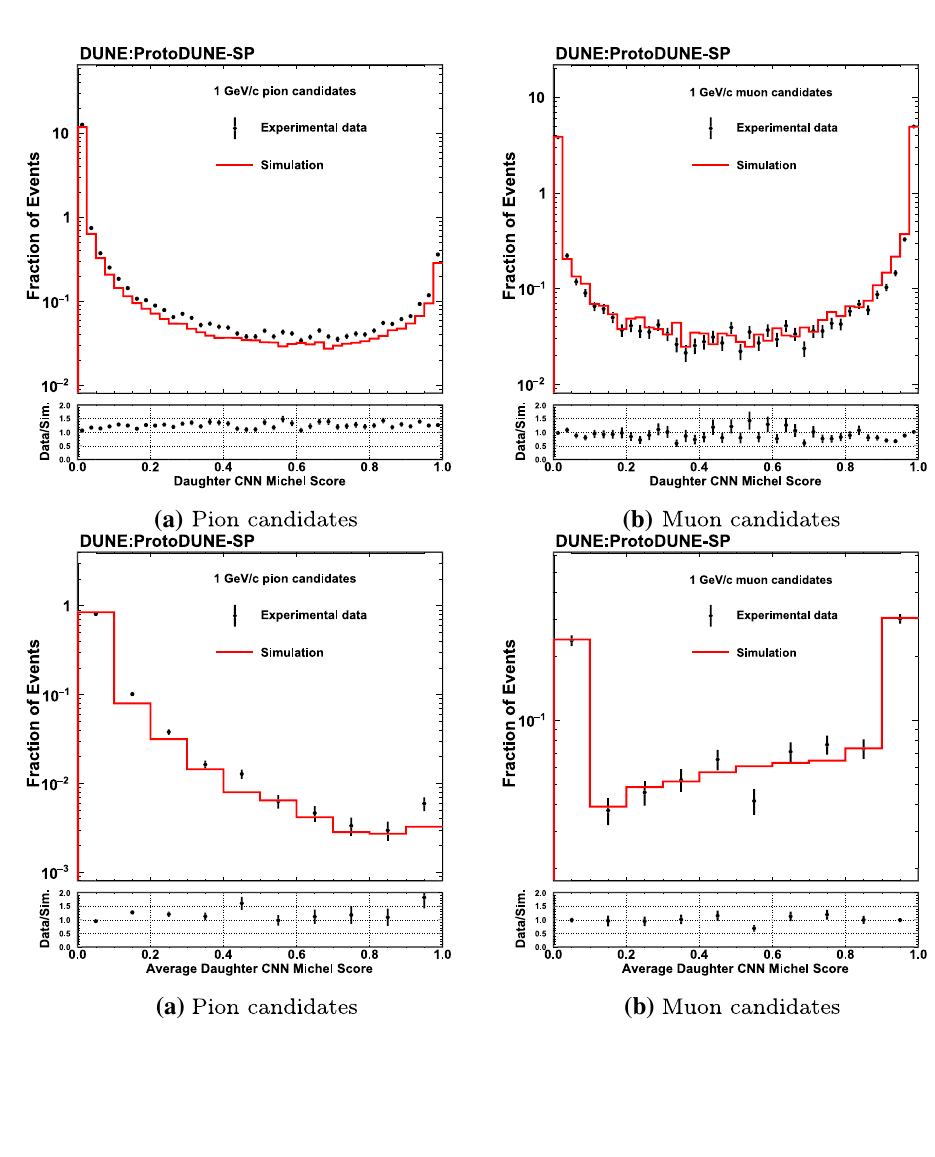
hit. The box surrounding the track end point is used to select the daugh- ter hits. The average daughter Michel score is 0.005 for the pion event and 1.000 for the muon event